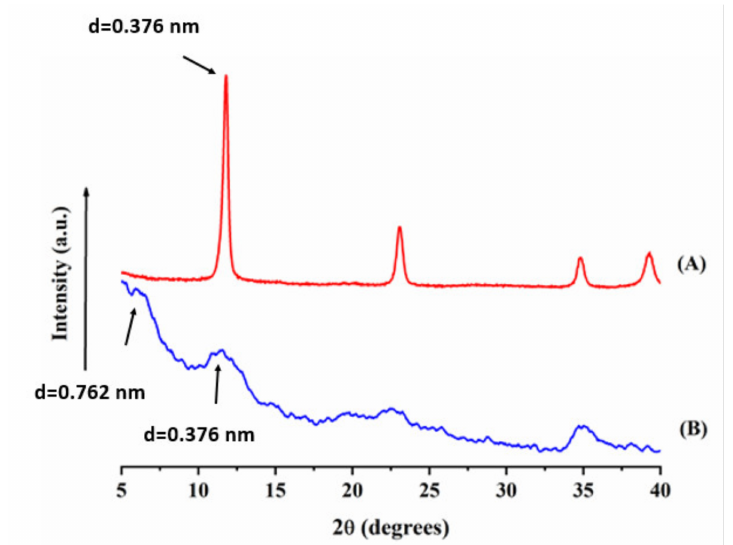
Figure 1. XRD of the pristine LDH with chloride anion ( A ) and the LDH modified with MA ( B